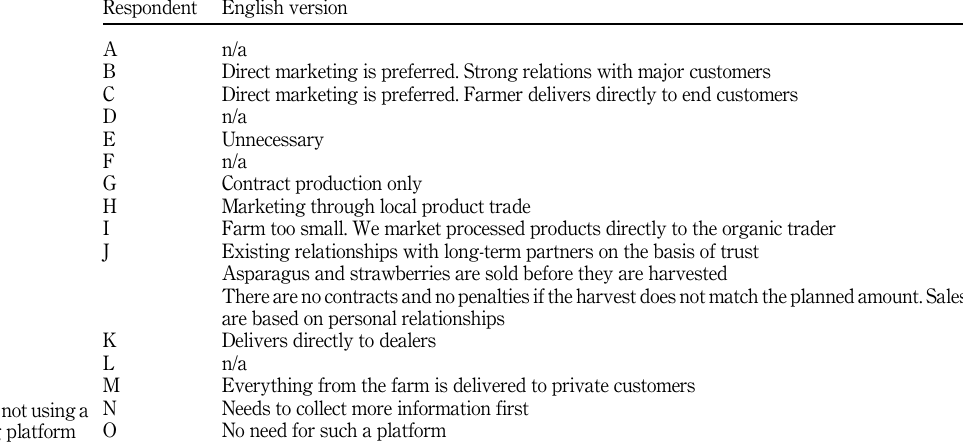
Table 7. Reasons for not using a web trading